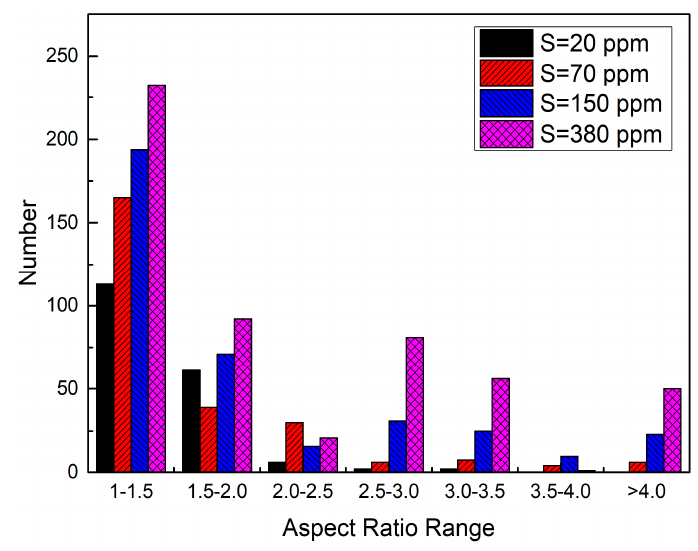
Figure 7. Aspect ratio distribution of MnS inclusion in the steel with different sulfur content.